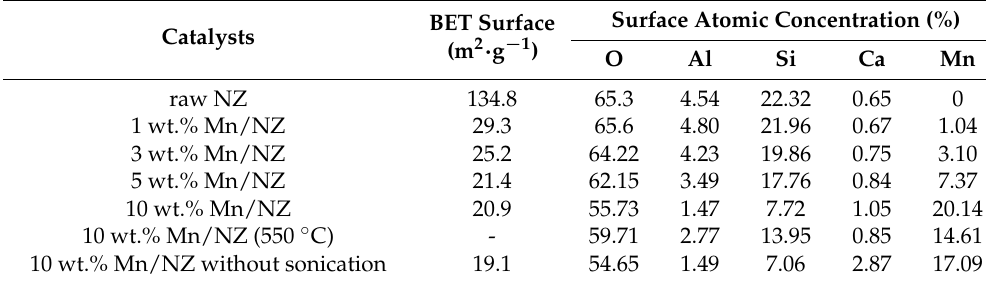
Table 1. Characteristics of the Mn-impregnated natural zeolite